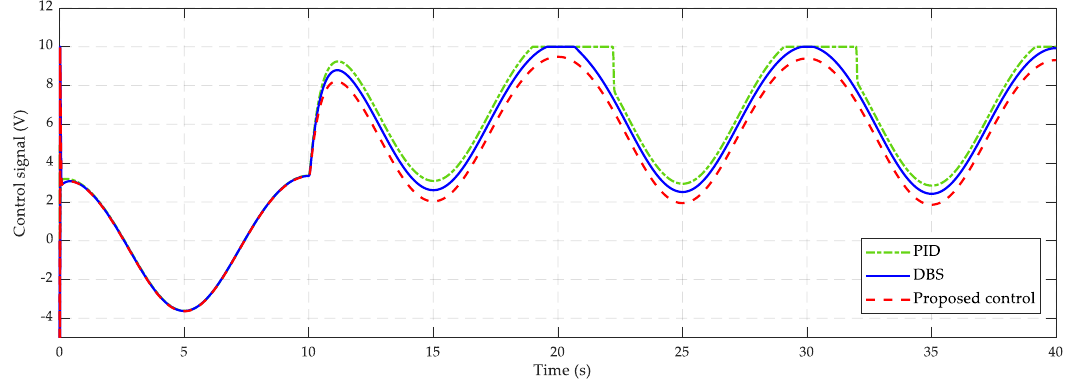
Figure 11. The input control signals.